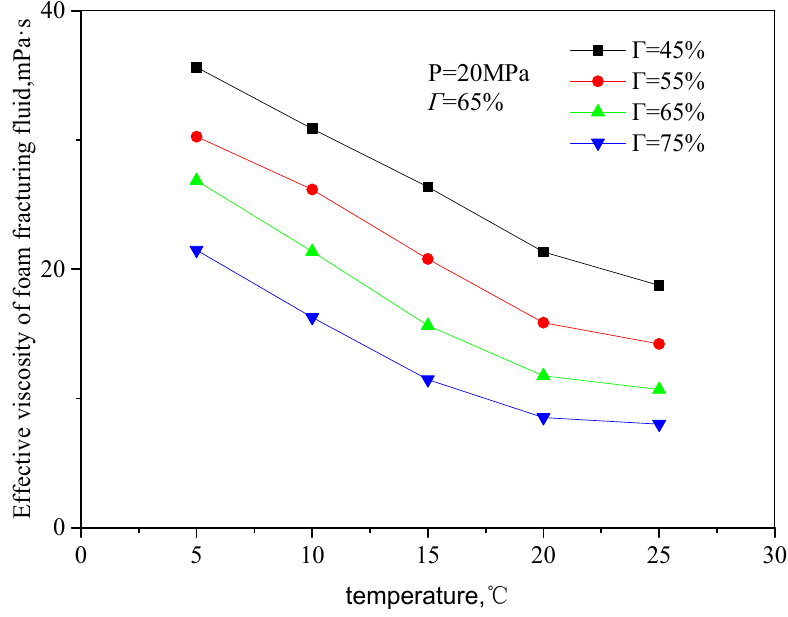
Figure 6. Variation curve of effective viscosity with temperature (unfoamed, shear rate 1000 s − 1 ).